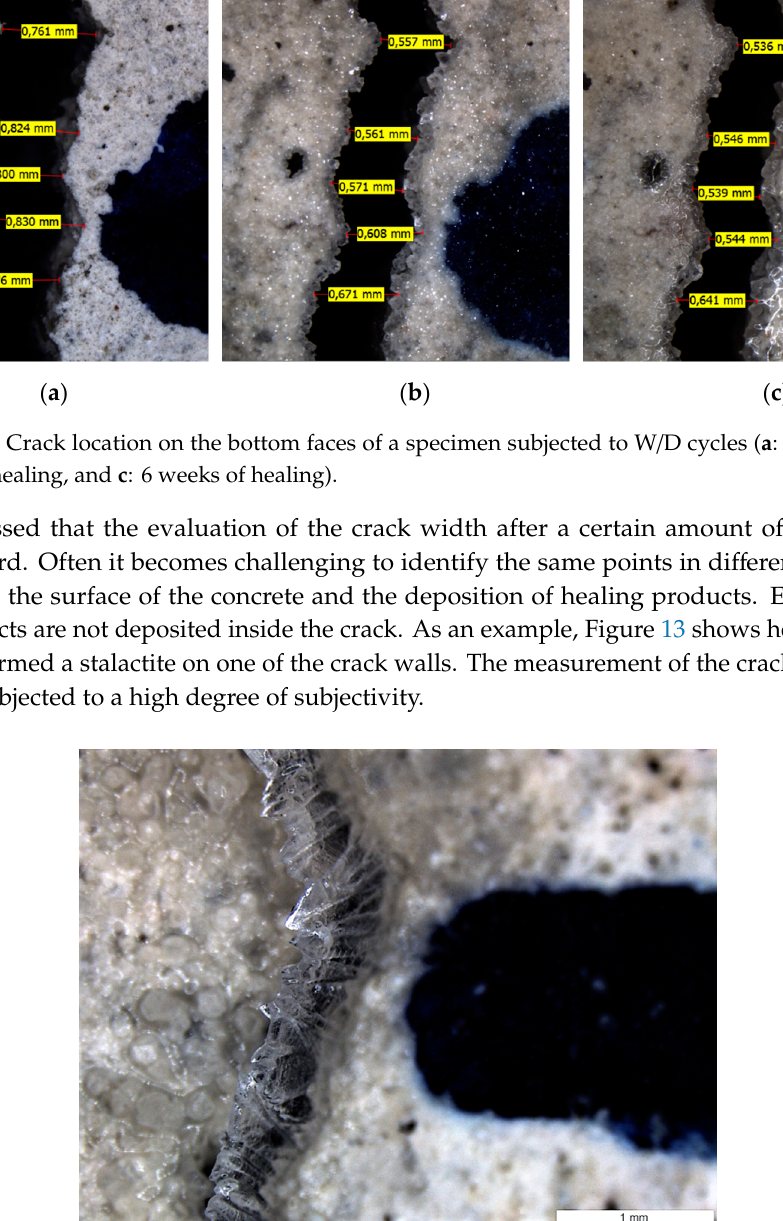
Figure 13. Formation of stalactites on a crack location on the bottom face of a specimen subjected to W/D